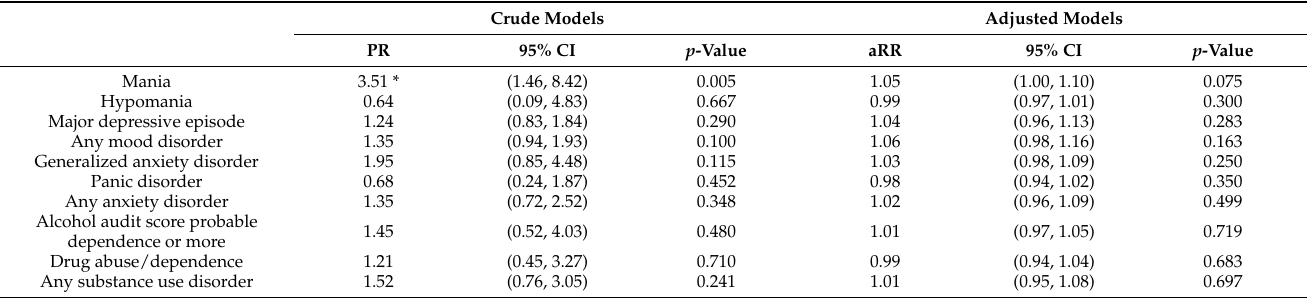
Table 2. Baseline DSM-5 Internet Gaming Disorder as a predictor of individual and group of disorders at follow-up. Weighted crude and adjusted models. Crude